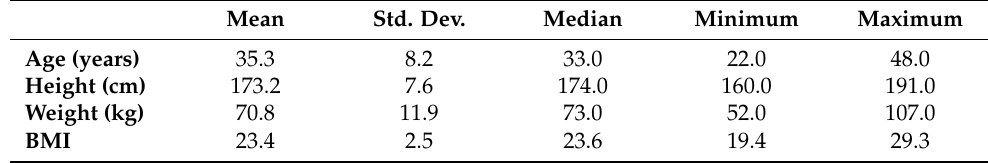
Table 1. Participant characteristics.